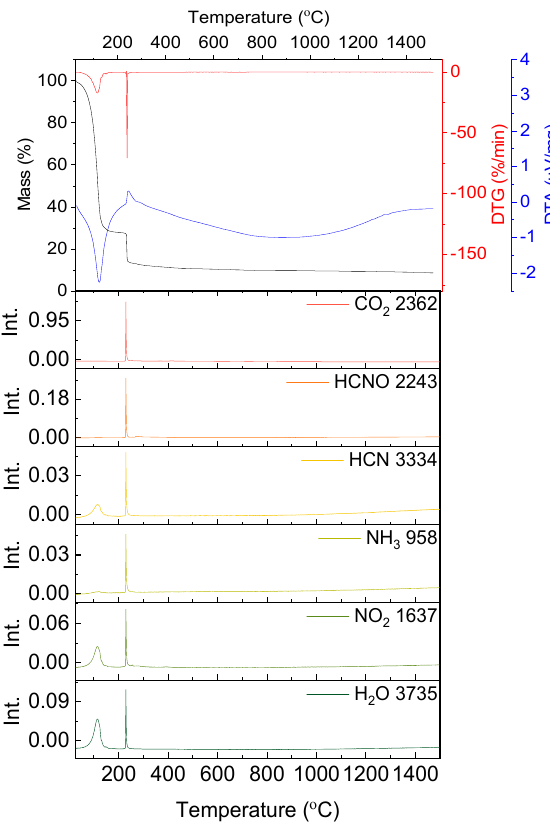
Figure 3. Results of the thermal analysis performed in synthetic air on the water solution containing yttrium nitrate and glycine; absorbance intensities of traces for wavenumbers: 2362, 2243, 3324, 958, 1637 and 3735 cm − 1 corresponding to absorbance peaks of CO 2 , HCNO, HCN, NH 3 , NO 2 and H 2 O, respectively.